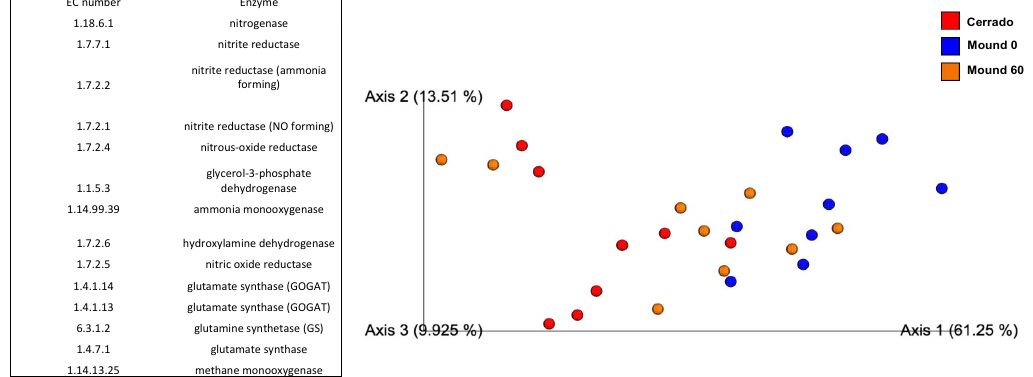
Figure A5. Principal component analysis (PCoA) of the functional inference data from mound soil (60 cm), mound surface (0 cm), and Cerrado soil (60 cm) samples. The principal component coordinates were calculated with the Bray–Curtis dissimilarity matrix and separated the samples in red (Cerrado), blue (mound 0), and orange (mound 60) (Axis–61.25%; Axis 2–13.51%, Axis 3–9.925%). The enzymes shown are common to all samples and participate in the nitrogen cycle according to KEGG database.